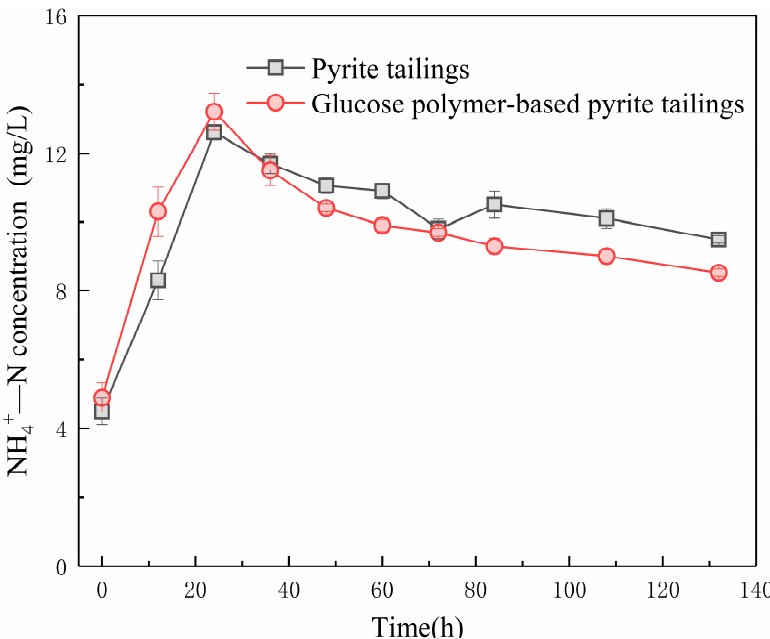
Figure 6. Variation of NH 4+ -N concentration in denitrification system before and after pyrite tailings coating.